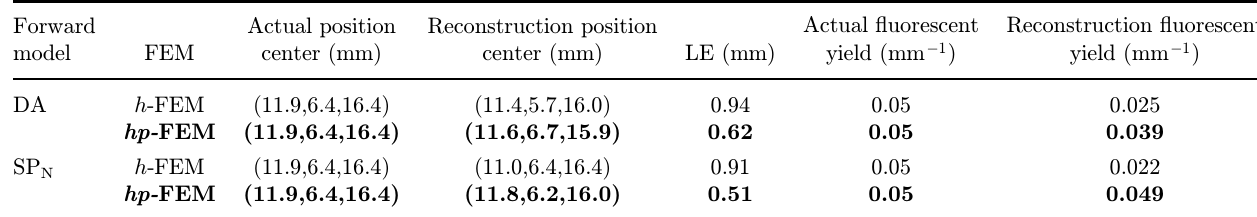
Table 3. Quantitative comparison between hp -FEM and h -FEM.